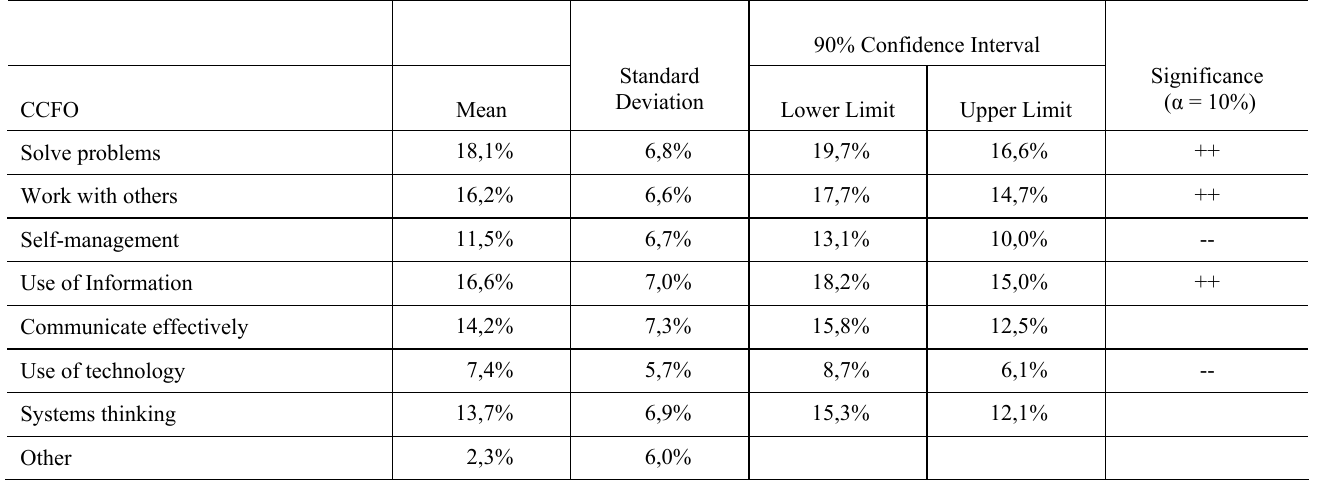
Table 3: Table of sample means and standard deviations of CCFO